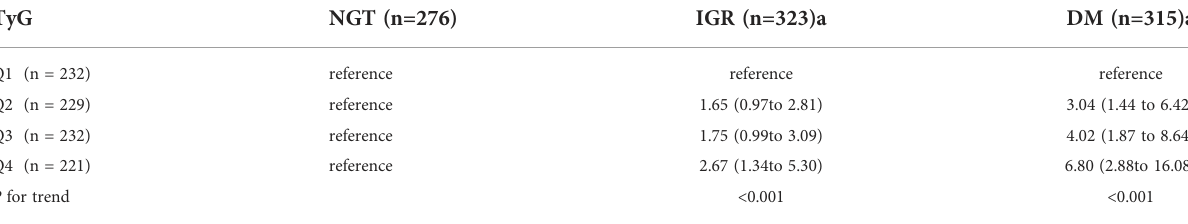
TABLE 6 Polytomous logistic regression estimates for ORs of each category of TyG with different glucose statuses.